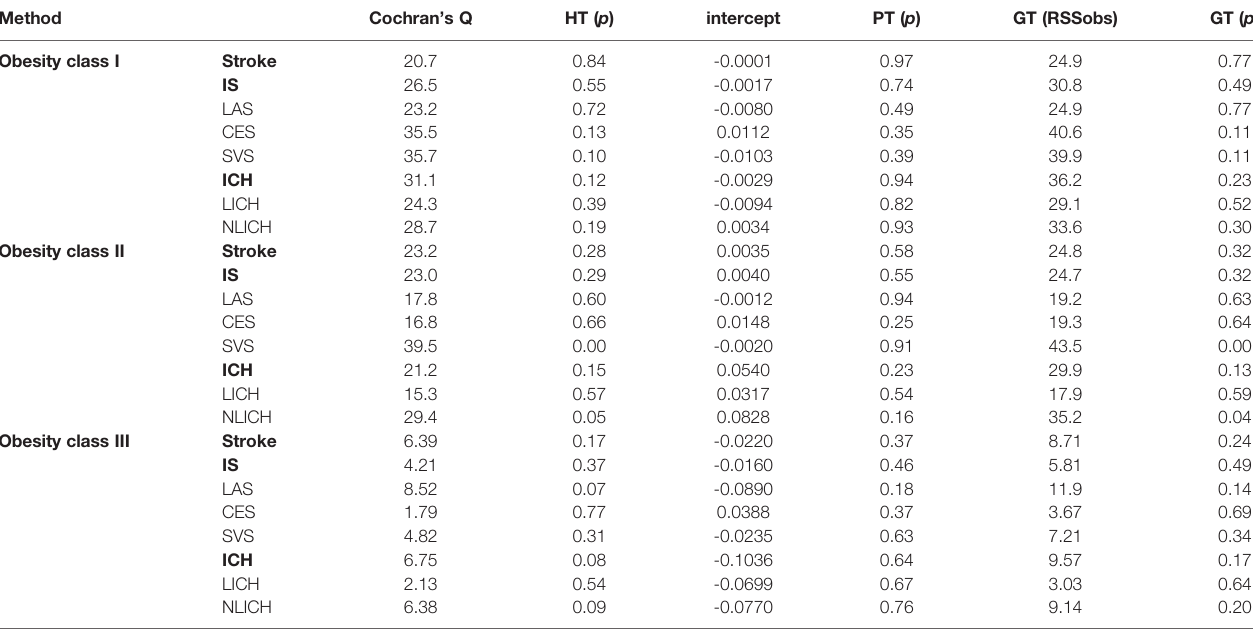
TABLE 3 | The outcome of the sensitivity analysis of obesity with the risk of